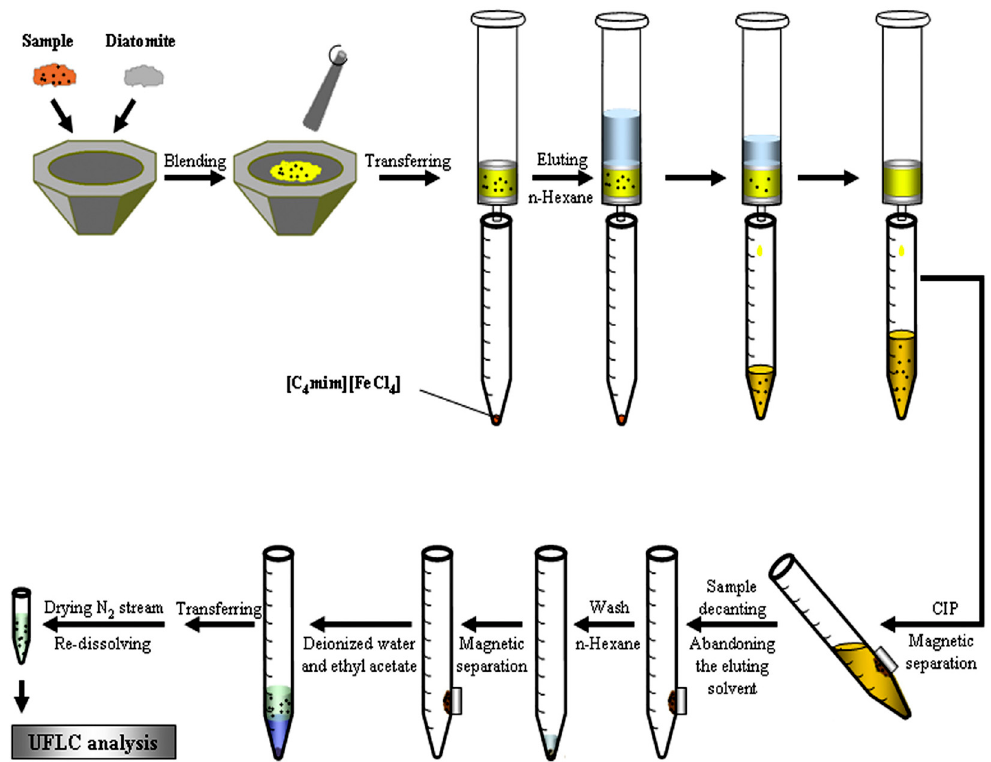
Figure 5. Schematic diagram for the MSPD-DLLME extraction procedure. Reproduced with permission from [54]. Copyright Elsevier, 2015.